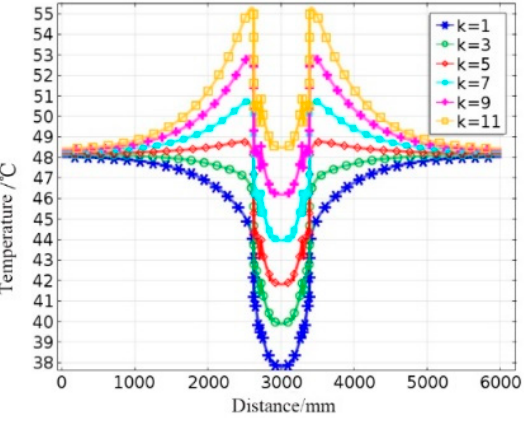
Figure 18. Surface axial temperature distribution curve of cable with different K values.